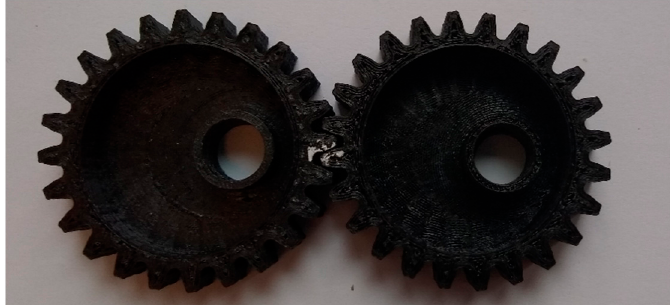
Figure 30. 3D printing of a designed elliptical gear.